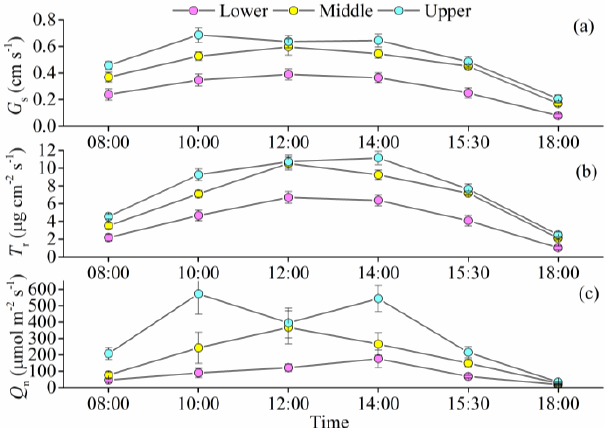
Figure 9. Diurnal variation of ( a ) the leaf stomatal conductance ( G s ), ( b ) leaf transpiration rate ( T r ) and ( c ) photosynthetic photon flux density ( Q n ) in the lower, middle and upper canopy parts of the sample tree on 21 July 2010.